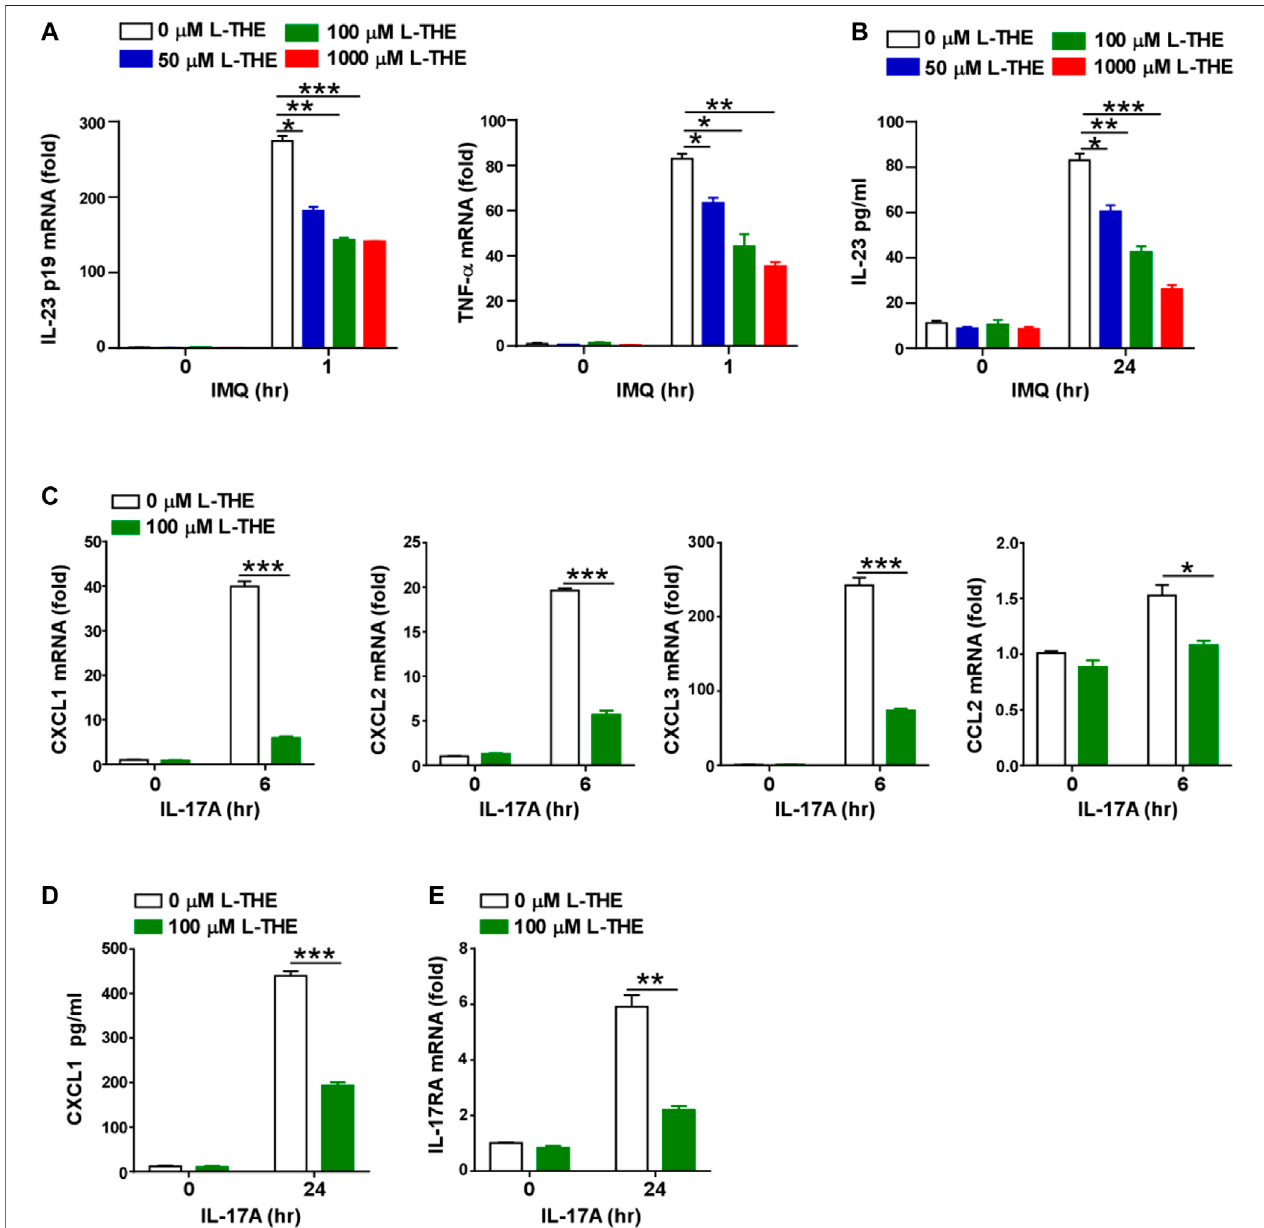
FIGURE7| L-THEinhibitestheexpressionofIL-23andchemokines invitro . (A) Q-PCRanalysisofIL-23p19andTNF- α inmRNAinBMDCsweretreatedwith4 μ g/ ml IMQ for indicated time points after pretreatment with L-THE for 12 h. (B) ELISA analysis of IL-23 protein in BMDCs were treated with 4 μ g/ml IMQ for indicated time pointsafterpretreatmentwithL-THEfor12 h. (C) Q-PCRanalysisofCXCL1-3,andCCL2mRNAinmouseprimarykeratinocytesweretreatedwith100 ng/mlIL-17Afor indicated time points after pretreatment with L-THE for 12 h. (D) ELISA analysis of CXCL1 protein in mouse primary keratinocytes were treated with 100 ng/ml IL- 17A forindicatedtime points after pretreatmentwith L-THE for 12 h. (E) Q-PCR analysis ofIL-17RAmRNA in mouse primary keratinocytes weretreated with 100 ng/ml IL-17A for indicated time points after pretreatment with L-THE for 12 h. Data is representative of three independent experiments. p values are determined by two-way ANOVA. *, p < 0.05; **, p < 0.01; ***, p < 0.001.